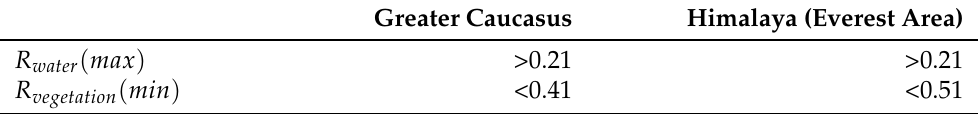
Table 1. Example of thresholds, that were applied for annual resolution glacial lake mapping. Greater